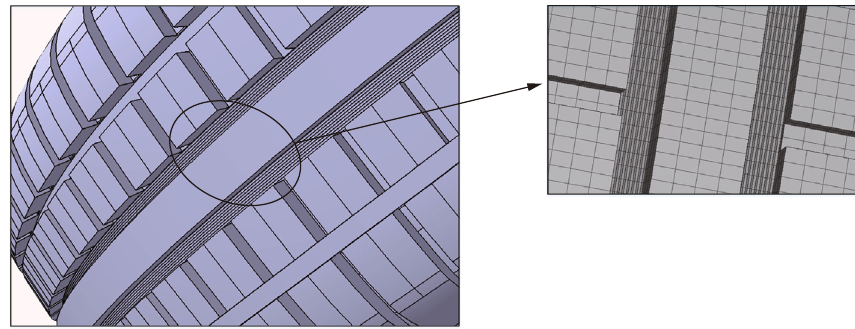
Figure 13: The bionic tire model.